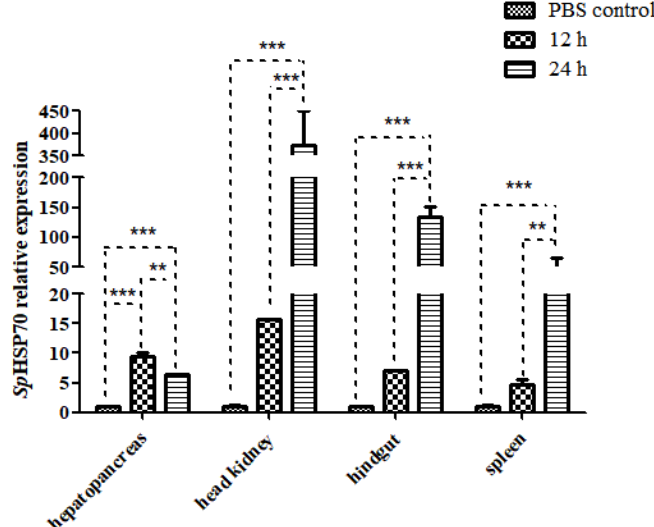
Figure 8. Transcript level of Sp HSP70 at different times after LPS challenge. Each value represents a mean ± SD ( n = 4 fish per group); statistical significance was decided using one-way ANOVA followed by Tukey tests. Note: an asterisk (*) over a column represents a statistically significant difference, two for <0.01 and three for <0.001. n = 4.